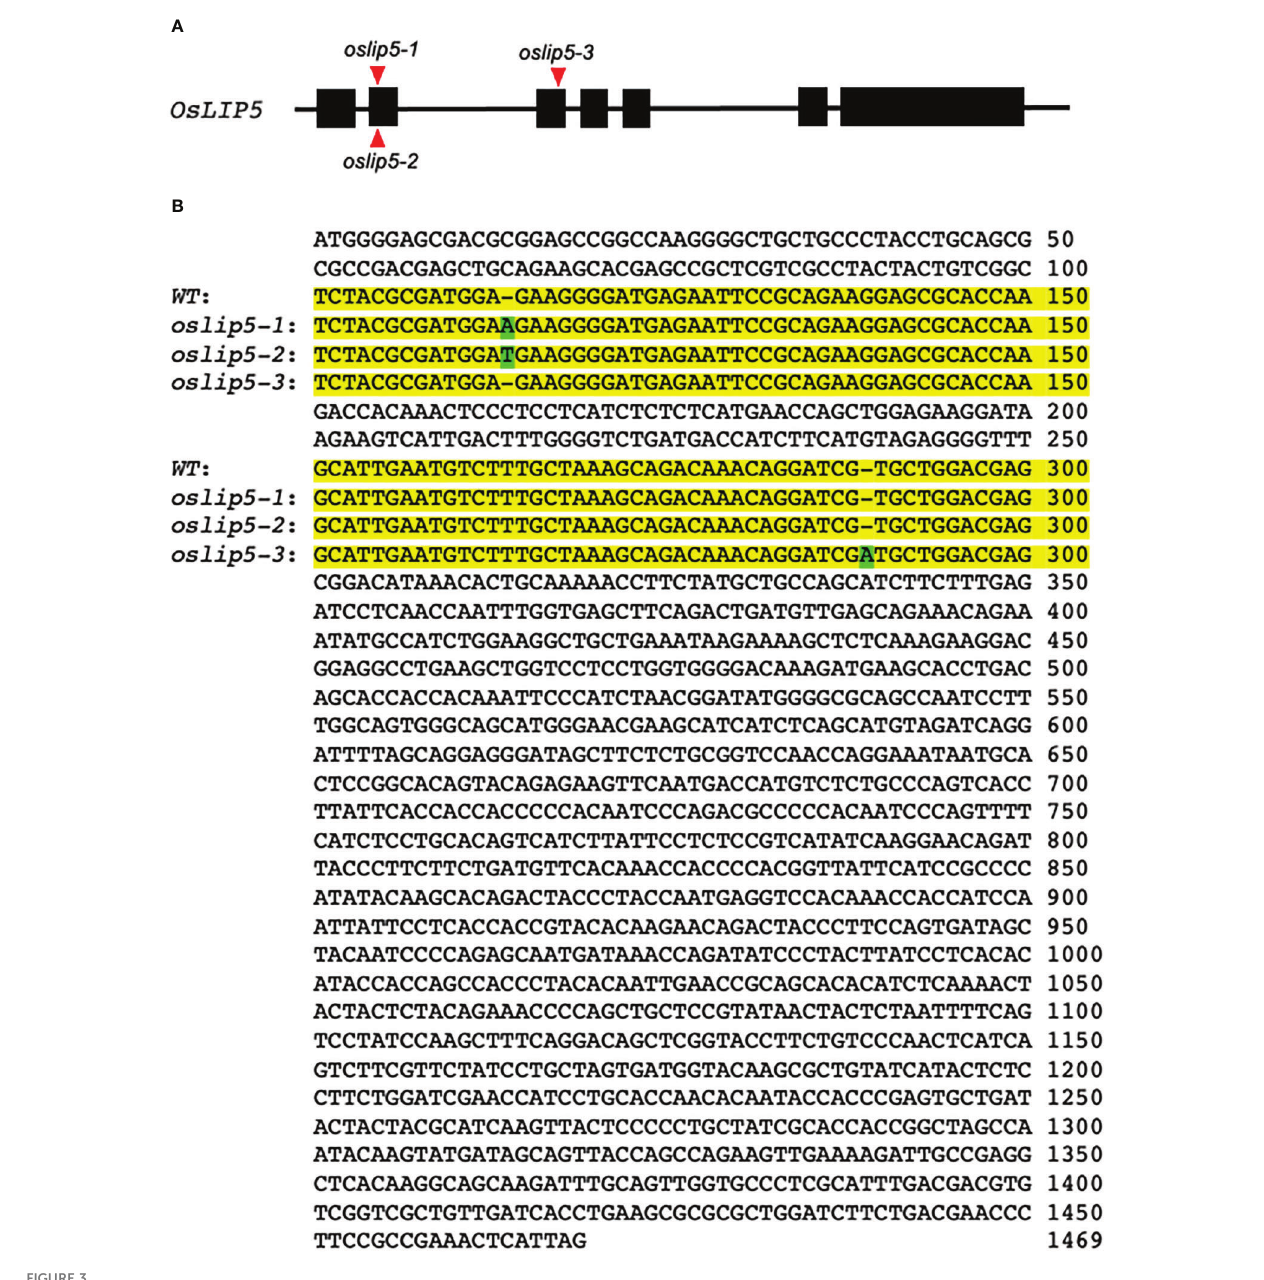
FIGURE 3 Targeted mutations of rice OsLIP5 gene using CRISPR/cas9 genome editing. (A) Rice OsLIP5 gene structure and the positions of three oslip5 mutations on their genomic sequences as indicated by red arrowheads. (B) Comparison of OsLIP5 coding sequences in WT and three oslip5 mutants. The two target sides containing the mutations are in yellow background. Inserted basis in the three oslip5 mutants are in green